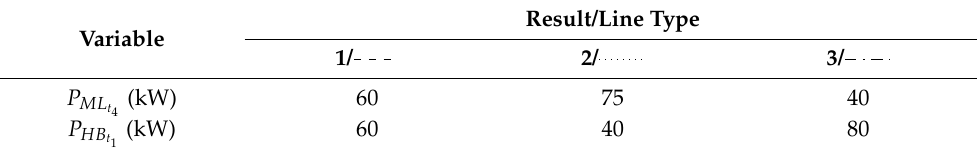
Table 7. Model inputs for system power and force trajectory